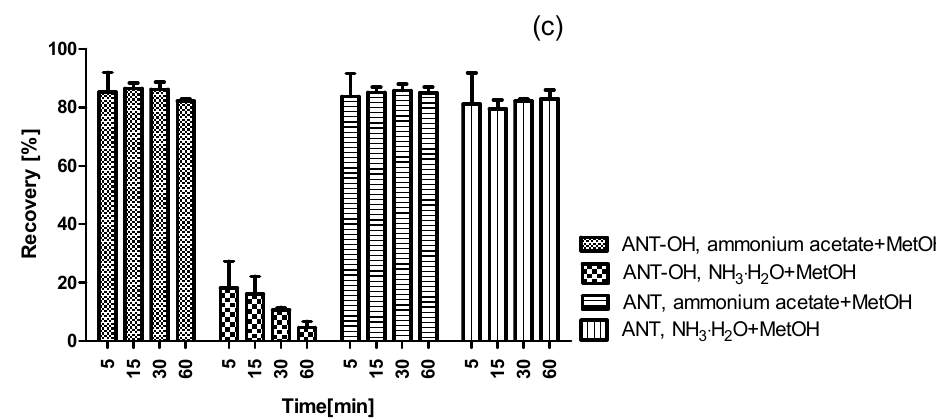
Figure A2. Results of optimization process of antazoline (ANT) and hydroxyantazoline (ANT-OH) extraction. Contact time of the analytes with the sorbent ( a ), type of washing solution ( b ) as well as time and type of elution solvent ( c ) were tested.